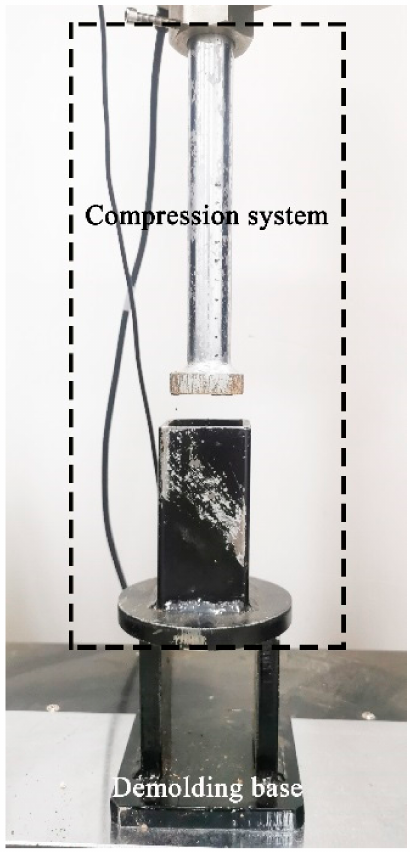
Figure 2. Compression molding device of peat substrate